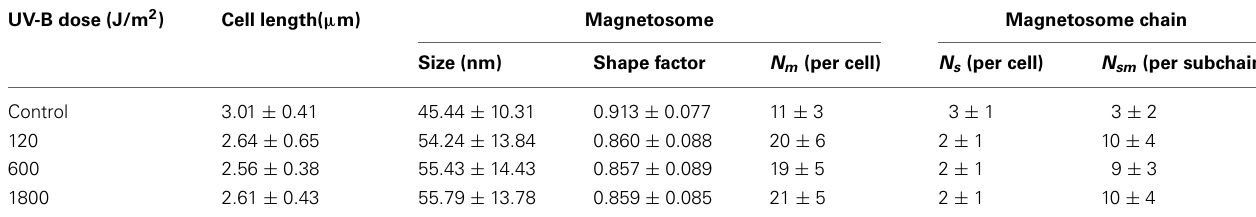
Table 1 | Cell length, magnetosome, and subchain information of the AMB-1 samples at different irradiation levels. UV-B dose (J/m 2